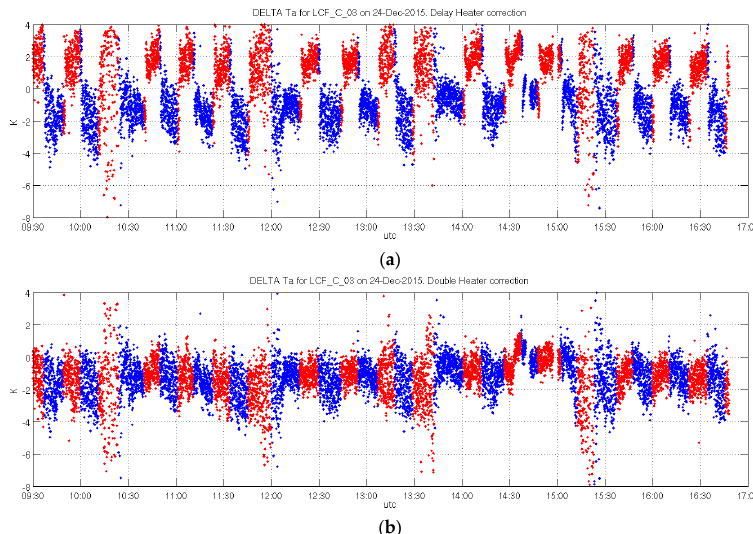
Figure 8. Difference between the antenna temperature measurement of receiver LCF_C_03, with respect to the average of all receivers, when applying the v620 delayed offset heater correction ( a ) and when applying the new v724 double exponential heater correction ( b ). The colour of the points in both plots indicates the status of the heater: red when the heater is on and blue when it is off.